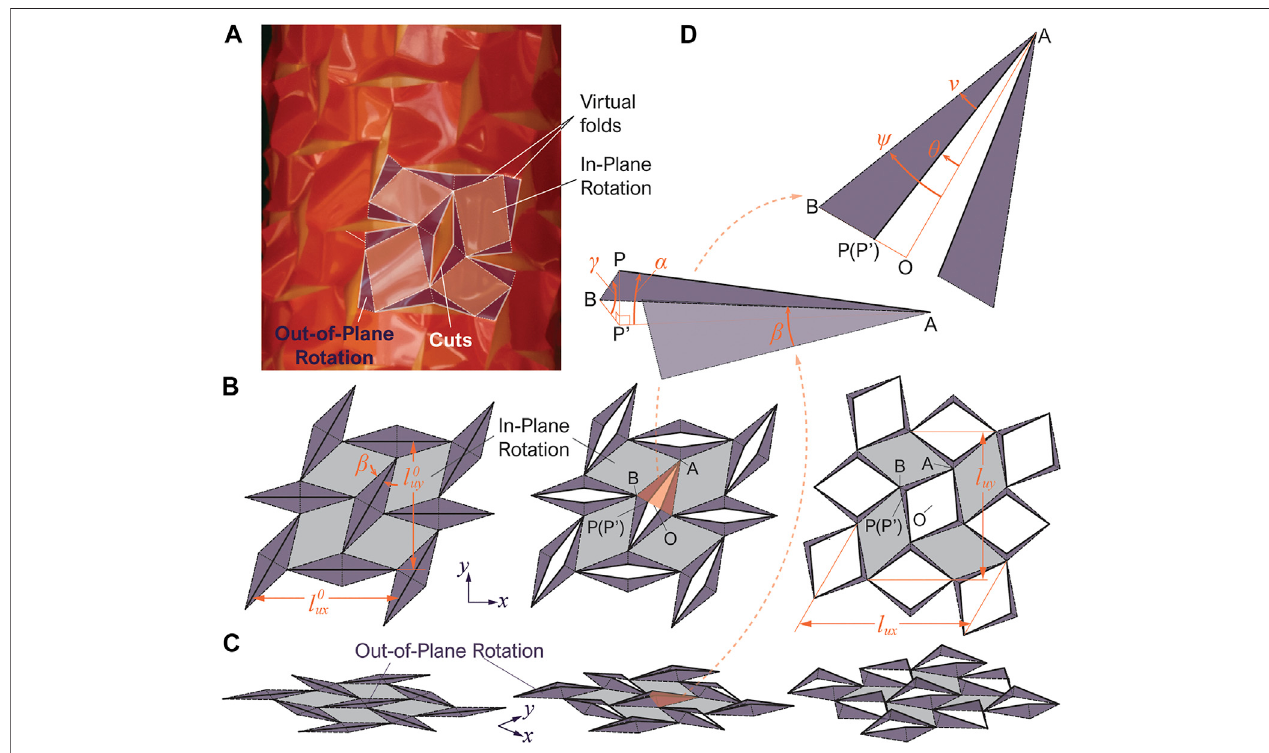
FIGURE 2 | 3D schematic diagrams showing the deformation of the kirigami skin based on the new kinematics model. (A) Another close-up view of the kirigami skin ’ s deformation, showing the “ virtual ” hinge-like folds and rigid fl at facets. Here, the grey-colored parallelogram facets only rotate in-plane, while the purple-colored triangular facets rotates out-of-plane. The dashed lines are valley folds and the dotted lines are mountain folds. (B,C) Top view and isometric view of the unit cell ’ s deformation, respectively. (D) Close-up view of a pair of triangular facets, showing the important geometric parameters.